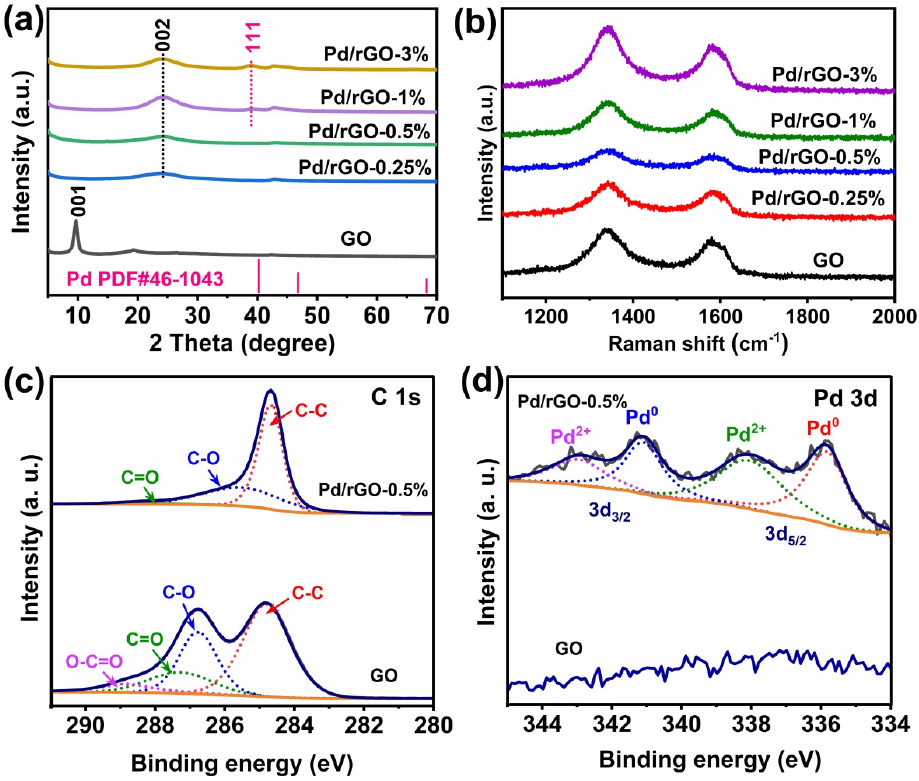
Figure 1. ( a ) XRD patterns and ( b ) Raman spectra of GO, Pd/rGO-0.25%, Pd/rGO-0.5%, Pd/rGO-1%, and Pd/rGO-3%; XPS spectra of ( c ) C 1s and ( d ) Pd 3d of the bare GO and Pd/rGO-0.5%.